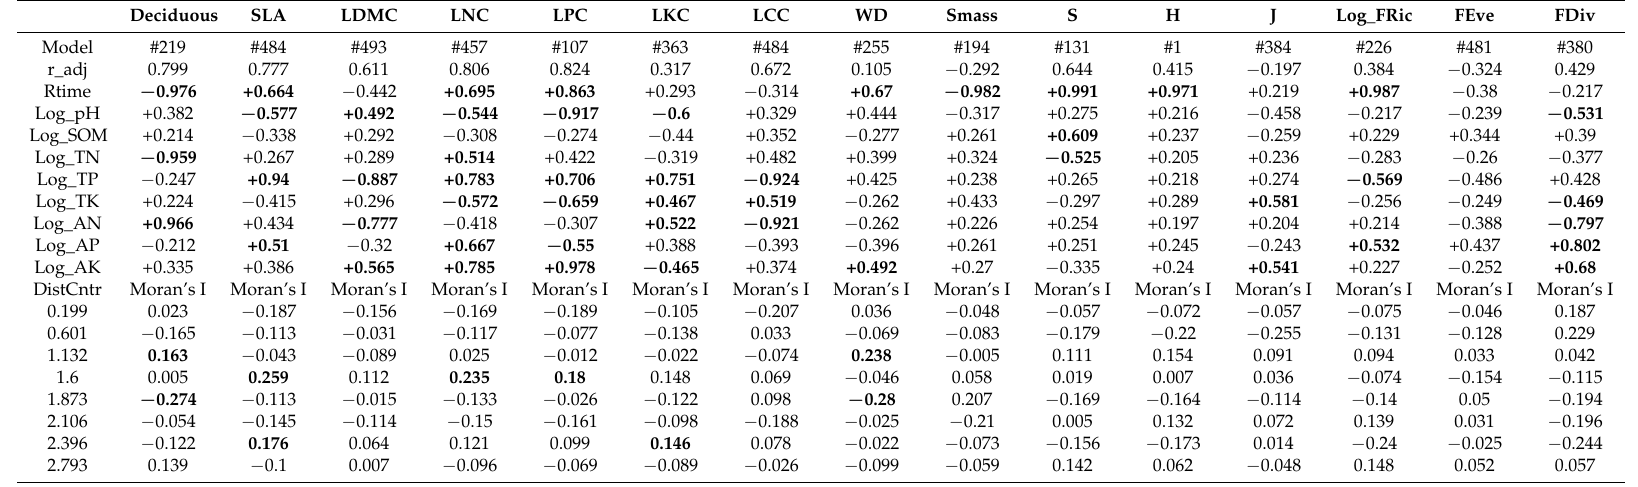
Table 2. The selected models with delta Akaike information criterion (AIC), the importance of each environment parameter, the correlation direction, and residual spatial autocorrelation (RSA) (Moran’s values, p < 0.05, are in bold). The nine functional traits using community-weighted means and functional diversity were computed based on tree basal area. The data of environmental factors and functional richness, were log-transformed. Parameters and abbreviation: deciduousness (Deciduous), specific leaf area (SLA); leaf dry matter content (LDMC); leaf nitrogen content (LNC); leaf phosphorus content (LPC); leaf potassium content (LKC); leaf carbon content (LCC); wood density (WD); and seed mass (SMass, g); species richness (S), Shannon -Weaver index (H), Pielu’s evenness (J), functional richness (FRic), functional Evenness (FEven), functional divergence (FDiv); soil pH (pH), soil organic matter content (SOM), total nitrogen content (TN), total phosphorus content (TP), total potassium content (TK), available nitrogen content (AN), available phosphorus content (AP), available potassium content (AK). Deciduous